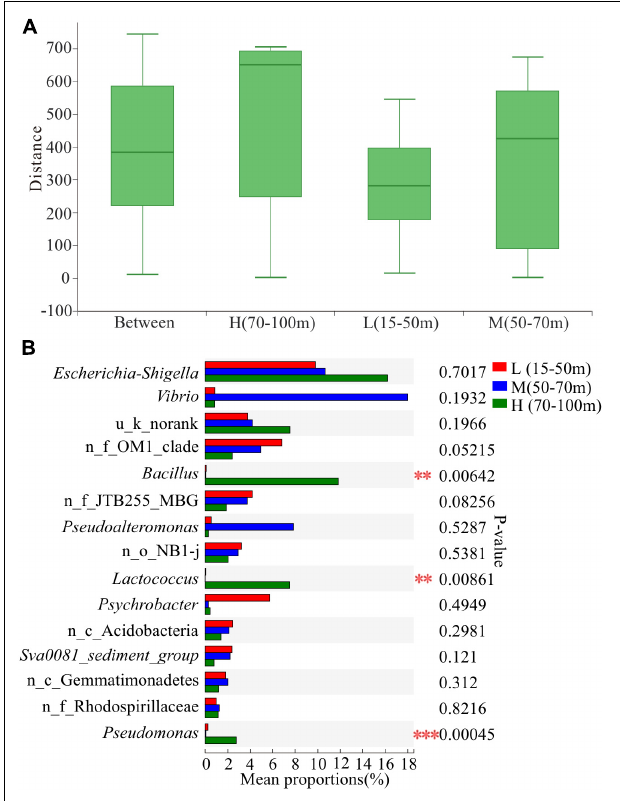
FIGURE 5 | Variation in microbial communities among three different depths. L, M, and H represent samples from depths of 15–50, 50–70, and 70–100 m, respectively. (A) Similarity analysis within and between depths. ANOSIM analysis based on Bray-Curtis distance of bacterial community structure at the OTU level ( p = 0.004, r = 0.1911). (B) Differences in bacterial abundance among three depths based on the Kruskal-Wallis test and the p-value